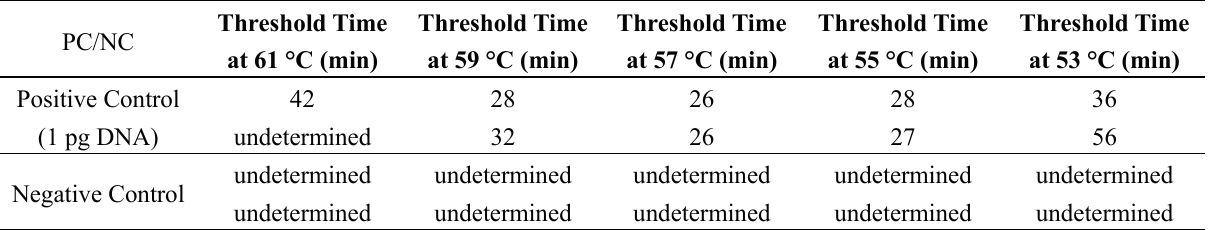
Table 2. Non-specific amplification of varying LAMP primer